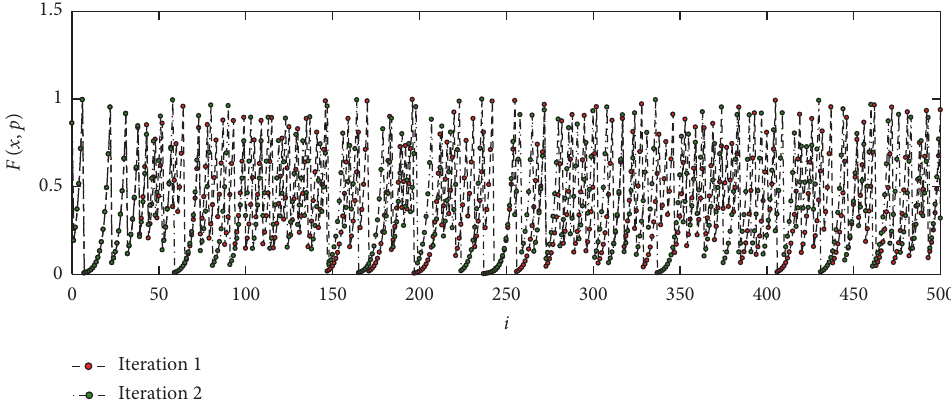
Figure 2: Iteration results of PLCM (1) with very close initial conditions and control parameters.